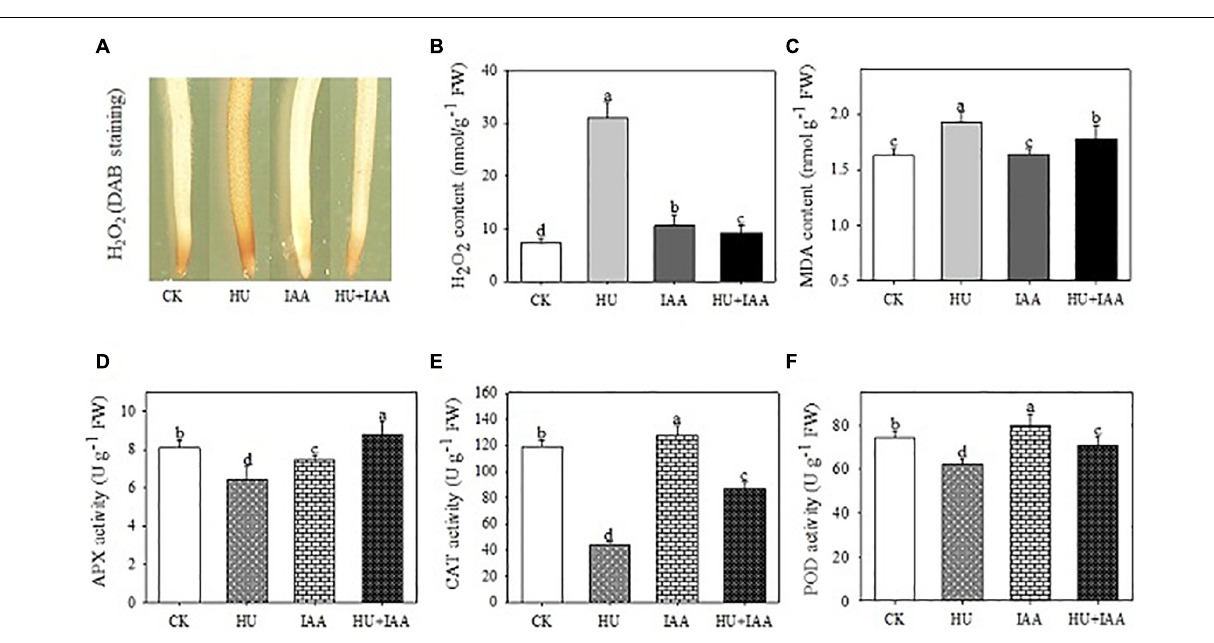
FIGURE 6 | Effect of IAA on physiological and biochemical parameters in the rice seedling exposed to HU stress. (A) DAB staining of roots, (B) H 2 O 2 content, (C) MDA content, (D) APX activity, (E) CAT activity, (F) POD activity. Different letters indicate significant differences between treatments, tested by the one-way ANOVA followed by Fisher’s test ( n = 3, p < 0.05). CK, Control; HU, Hydroxyurea; IAA, indole-3-acetic